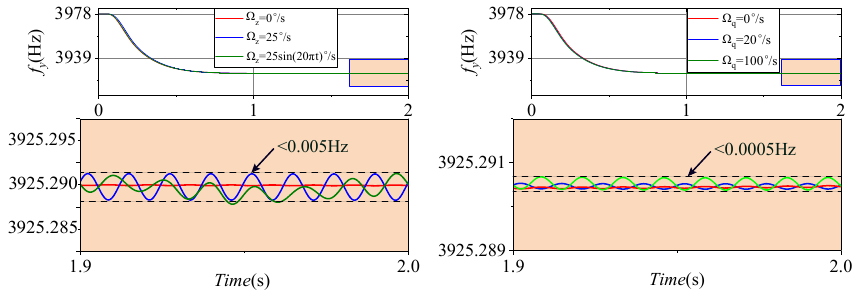
Figure 10. The disturbance of different Ω z ( left ) and Ω q ( right ) to f y